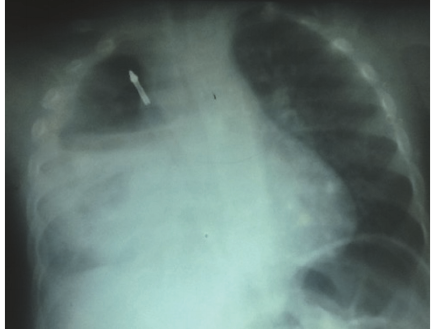
Figure 1: The type of impacted objects. A BIC pen and a 100 FCFA coin.